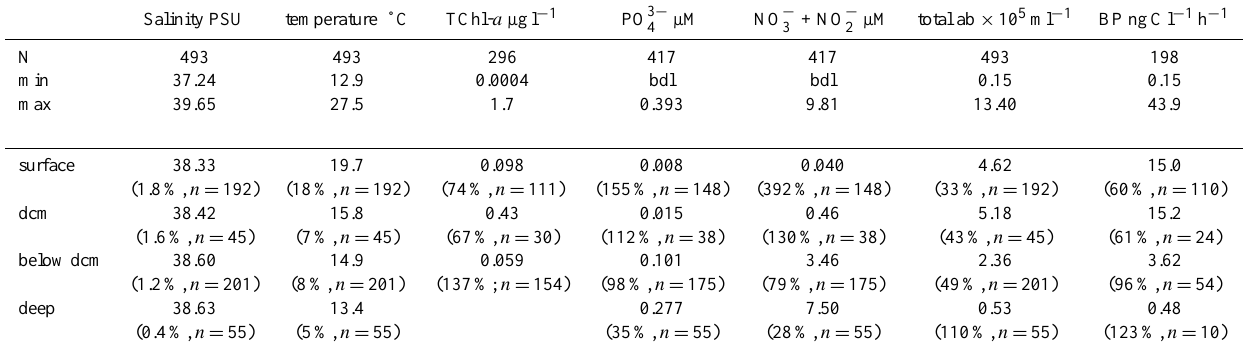
Table 1. Ranges of salinity, temperature, total chlorophyll- a (TChl- a ), phosphate (PO 3 − abundance (total ab), and bacterial production (BP) for the data set used for comparison of abundance and cytometric characteristics of HNA and LNA cells. Means, coefficient of variation and number of data for each group of water column partition: layers above the deep chlorophyll maximum (surface), layers at the deep chlorophyll maximum (“dcm”), layers below the dcm but above or equal to 250m (“below dcm”), and layers below 250m “deep”. bdl: below detection